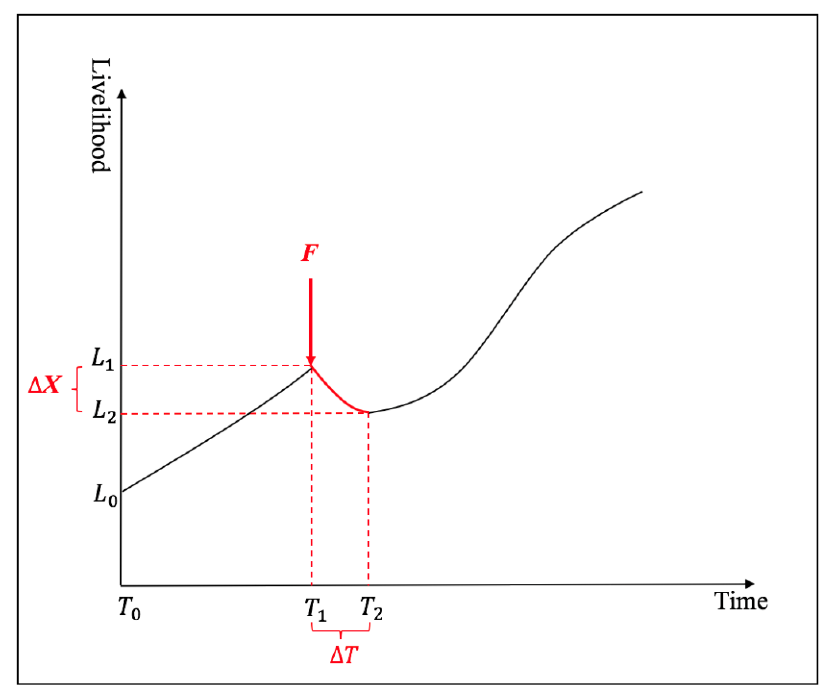
Figure 1. Theoretical framework of the livelihood change process of reservoir-a ff ected families (RAFs) (The study period is ∆ T , during which livelihood changes by ∆ X ). Source: designed by the